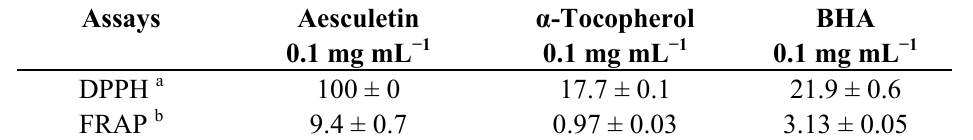
Table 4. Antioxidant activity of aesculetin, α -tocopherol and butylated hydroxyanisol